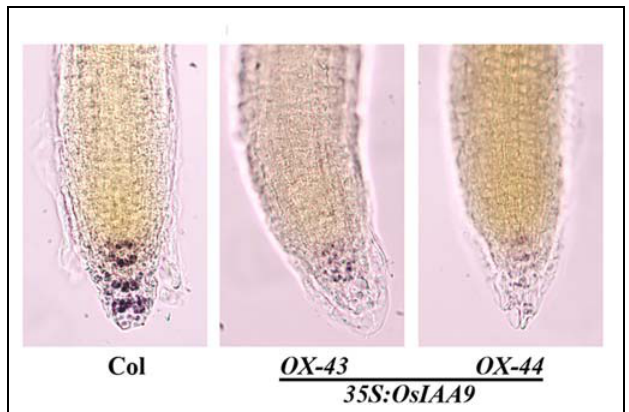
FIGURE 7 | Starch Granules formation in root tips of OsIAA9 transgenic plant seedlings. Four-day-old seedlings of Col wild type (left) and OsIAA9 transgenic plants (middle, right) grown on vertically oriented plates were fixed with FAA overnight at 4 ◦ c, washed once with 50% ethanol, stained with Lugol’s solution for 1 min, and chloral hydrate solution for 2 min before photographs were taken